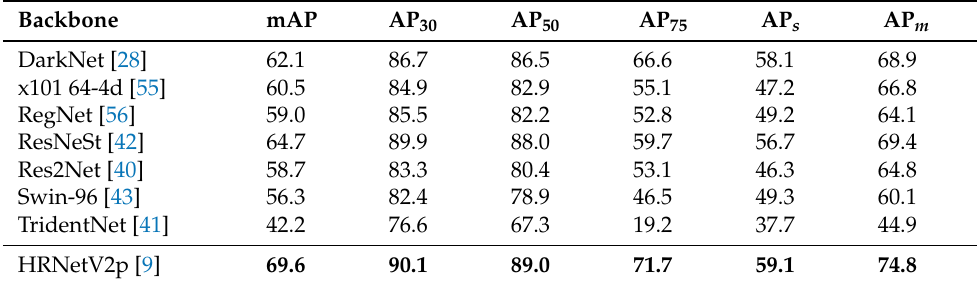
Table 2. Backbone testing results. The Cascade Mask R-CNN detector is used except for DarkNet, which is native to the YOLOv3 detector. The best result in each column is in